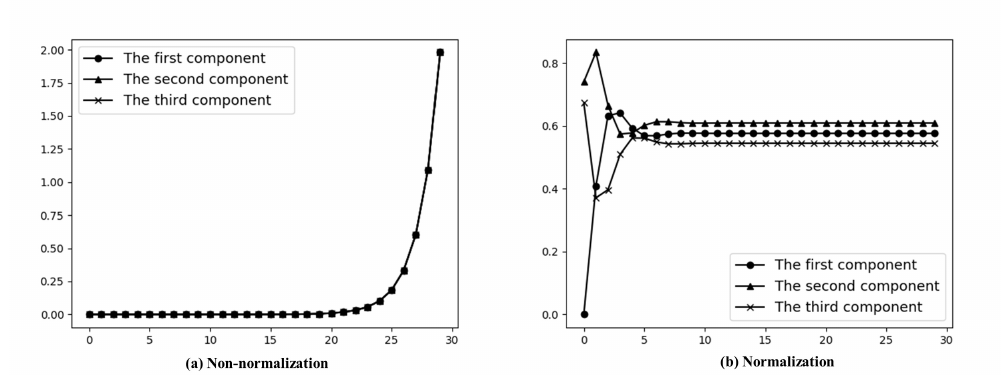
Figure 5. Label value of node 3 with non-normalization and normalization. The value increases exponentially without normalization (see ( a )), but tends to be stable after normalization (see ( b )).